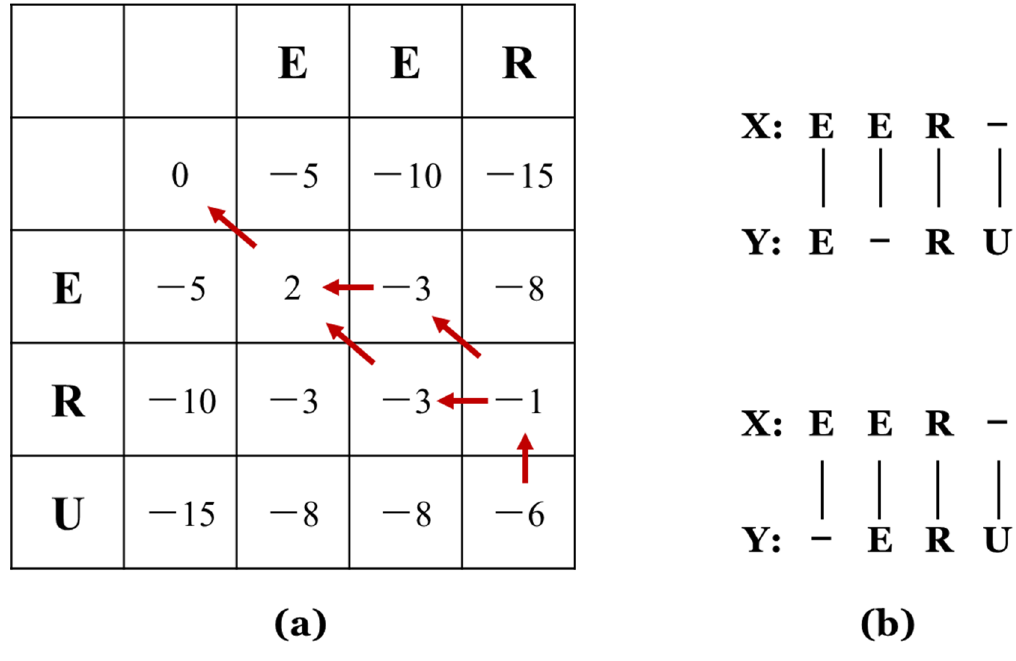
Figure 2. ( a ) The path of tracing backwards; ( b ) the optimal alignment results of the two sequences.